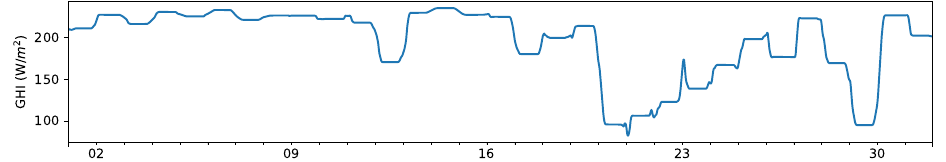
Figure 6. Trend component of GHI for December 2019.